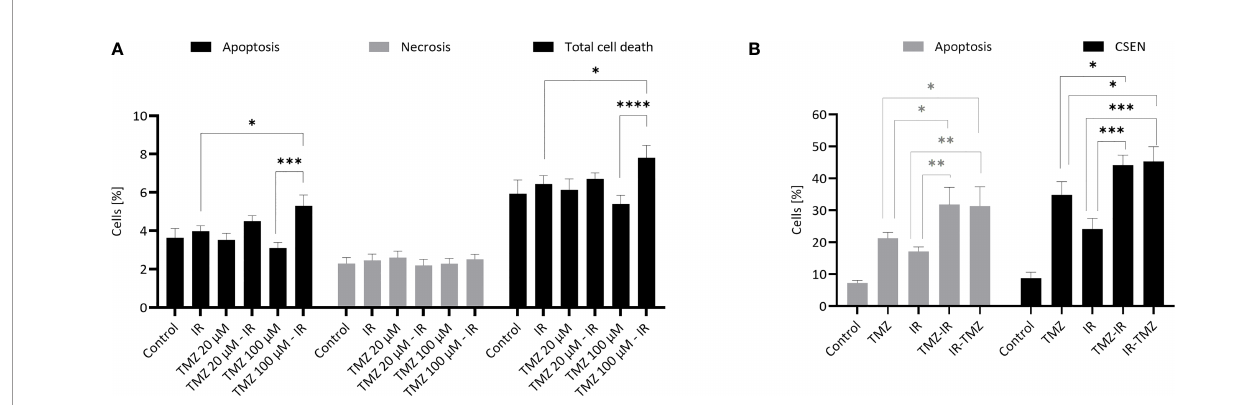
FIGURE 1 | TMZ and IR- induced apoptosis and senescence. (A) Effect of TMZ pretreatment on radiation-induced apoptosis. Human LN229 glioblastoma cells in the exponential growth phase were treated with TMZ (20 or 100 µM) and 3 h later irradiated with g -rays (6 Gy). Apoptosis (annexin V+, PI-), late apoptosis/necrosis (annexin V+, PI+) and total cell death were measured 5 h later by fl ow cytometry. Data are the mean of 4 independent experiments +/- SEM. *p < 0.05; ***< 0.001. (B) Effect of IR pre- and post-treatment on TMZ-induced apoptosis and cellular senescence. Human LN229 glioblastoma cells in the exponential growth phase were treated with TMZ (20 µM) and 3 h later irradiated with g -rays (6 Gy) (TMZ-IR). In a parallel setting, they were irradiated (6 Gy) and 6 h later treated with TMZ (20 µM) (IR-TMZ). Apoptosis (early apoptosis: annexin V+/PI-; late apoptosis: annexin V+/PI+) and senescence (C12FDG+) were measured 7 d later by fl ow cytometry. Data are the mean of 3-4 independent experiments +/- SEM. *p < 0.05; **< 0.01; ***< 0.001 ; ****<0.0001. Experiments were essentially performed as previously described